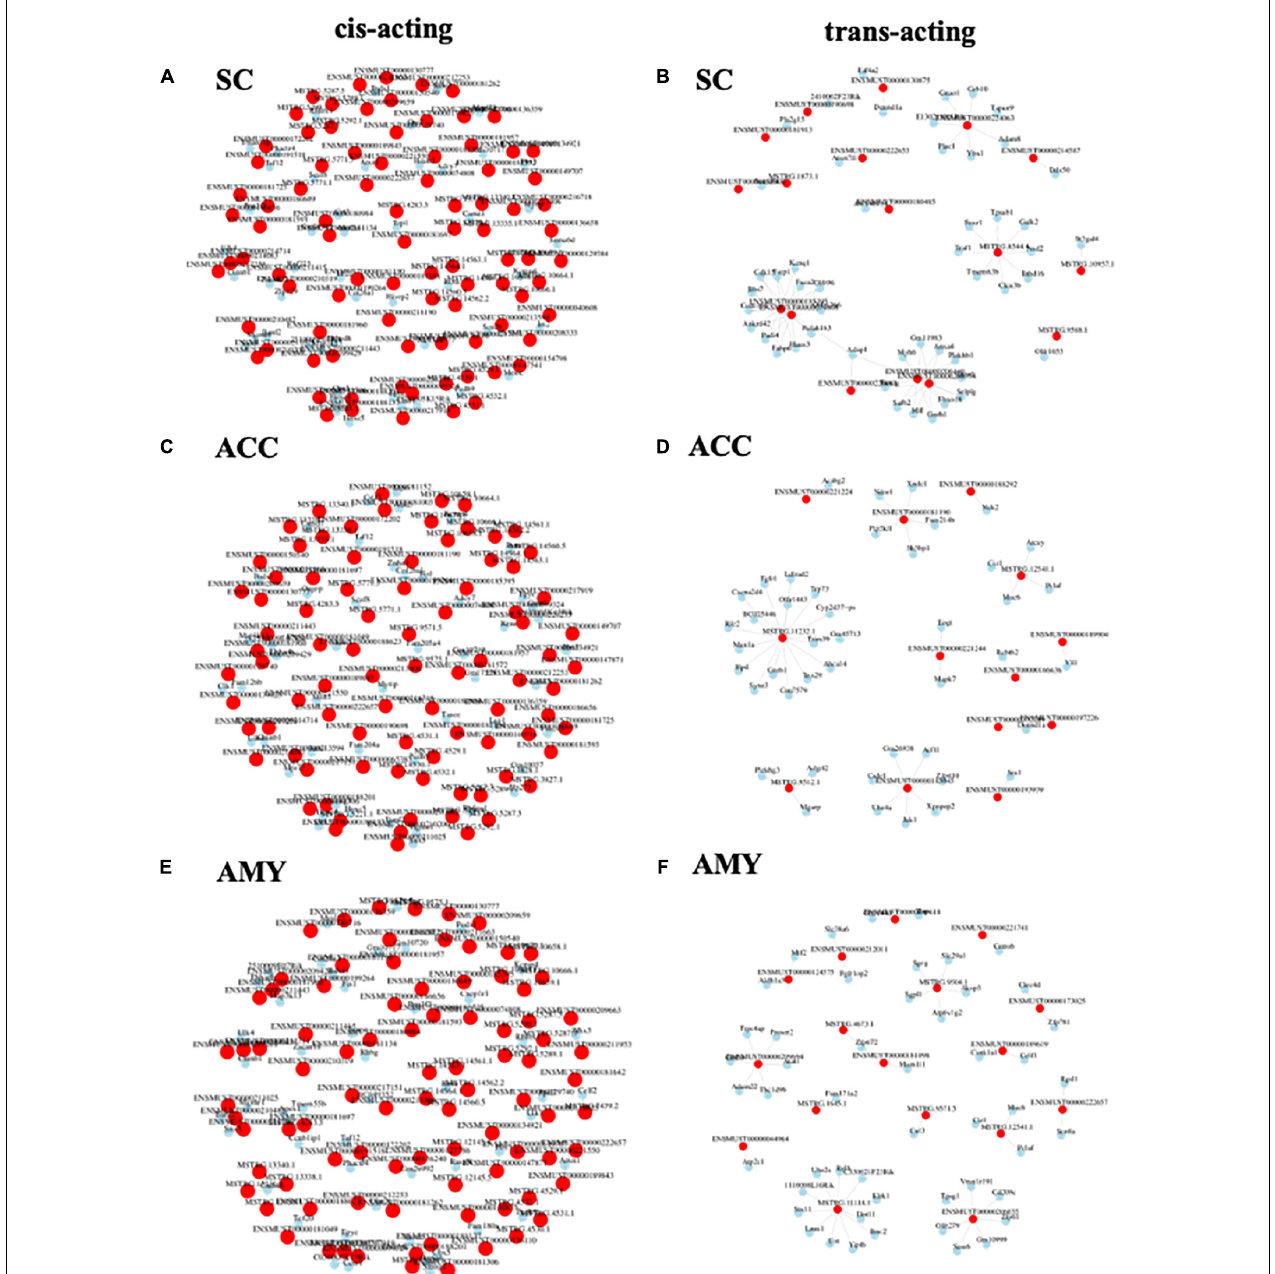
FIGURE 10 | Analysis of lncRNA–mRNA co-expression network in the SC, ACC, and AMY of SNL mice. (A,B) Co-expression network of cis-acting regulatory elements (A) and trans-acting regulatory elements (B) in the SC. (C,D) Co-expression network of cis-acting regulatory elements (C) and trans-acting regulatory elements (D) in the ACC. (E,F) The co-expression network of cis-acting regulatory elements (E) and trans-acting regulatory elements (F) in the AMY. LncRNA–mRNA co-expression network was constructed based on the Pearson correlation coefficients. Pink color nodes represent lncRNA, while blue nodes represent the co-expression